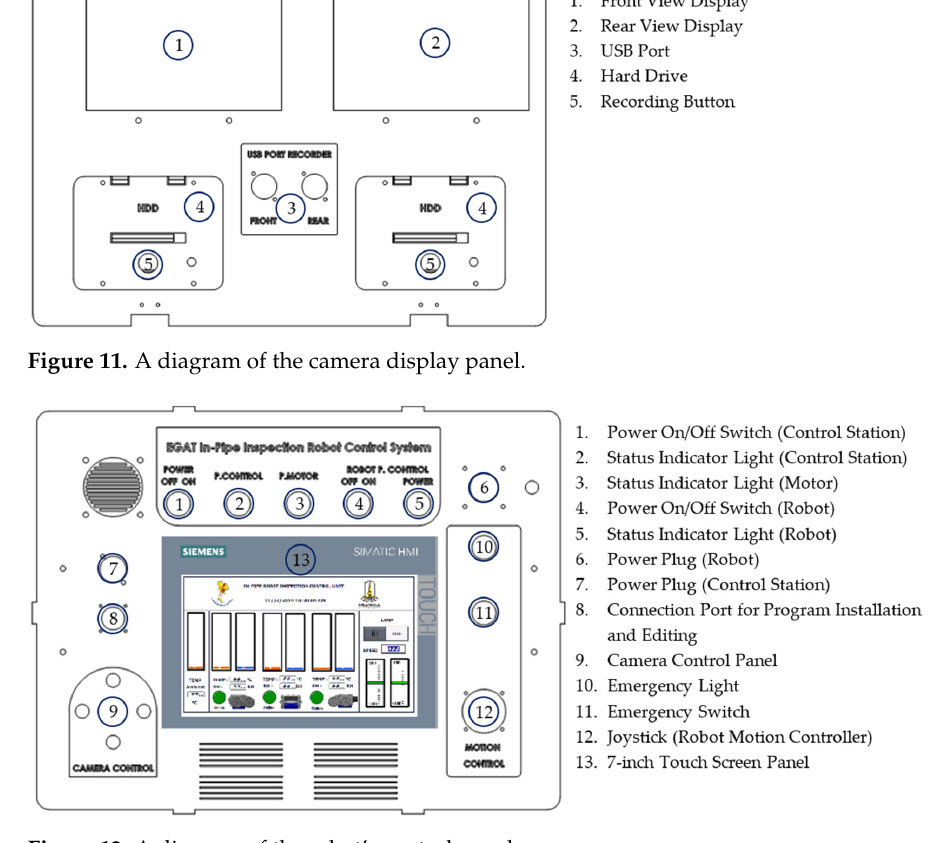
Figure 12. A diagram of the robot’s control panel.